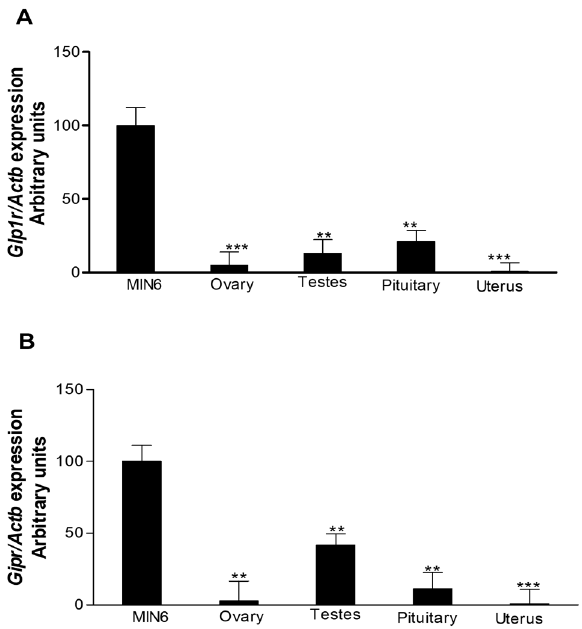
Figure 1. GLP-1 and GIP receptor gene expression in pituitary, ovary and uterine horn of female C57BL/6 mice. Relative mRNA expression (in %) in the pituitary, ovary and uterine horn of C57BL/6 mice. ( A ) GLP-1R and ( B ) GIPR mRNA expression. Values are mean ± SEM with n = 4. ** p < 0.01, *** p < 0.001 compared to insulin-secreting MIN6 cells.